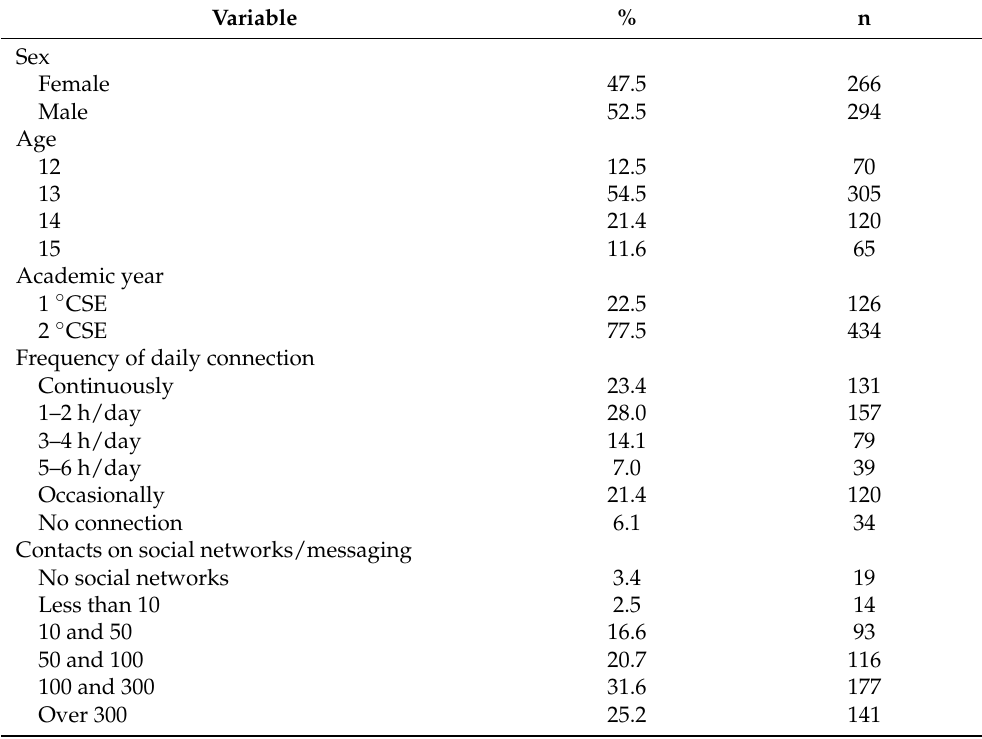
Table 1. Description of the sample. Qualitative